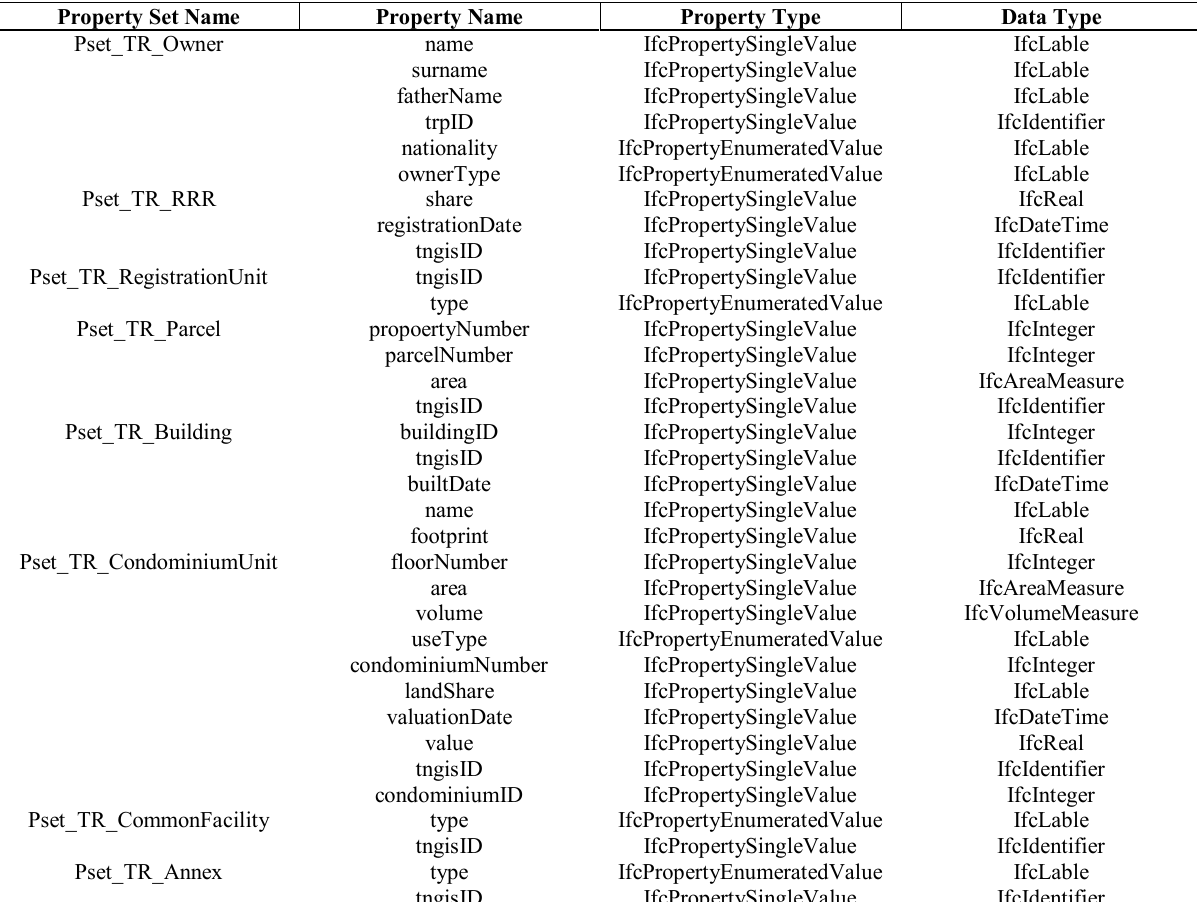
Table 1. Property set names, property names, property types, and data types that are used to depict the conceptual model.